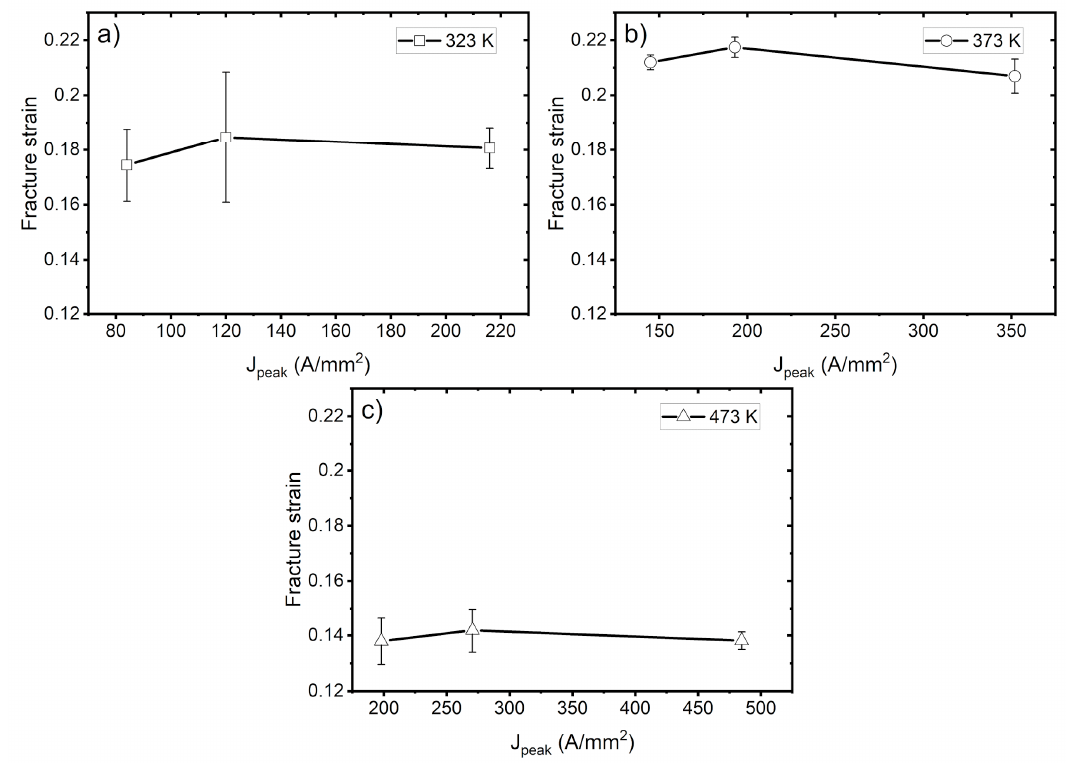
Figure 10. Fracture strain at various peak current densities at ( a ) 323 K, ( b ) 373 K, and ( c ) 473 K.